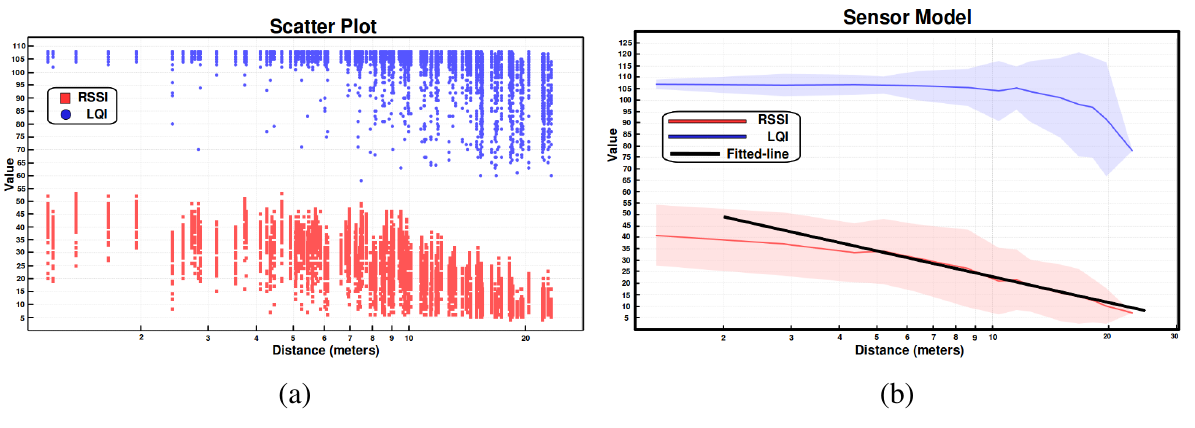
Figure 1. (a) Tmote indicators at different inter-node distances in an office-like environment, and (b) sensor model based on RF power signal strength